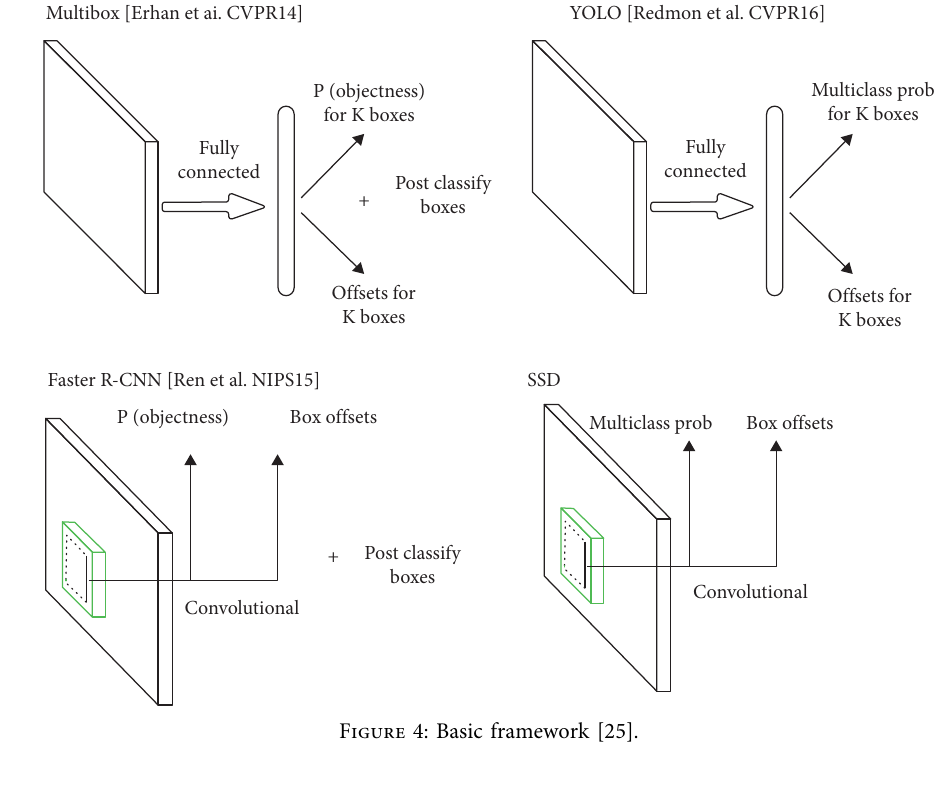
Figure 4: Basic framework